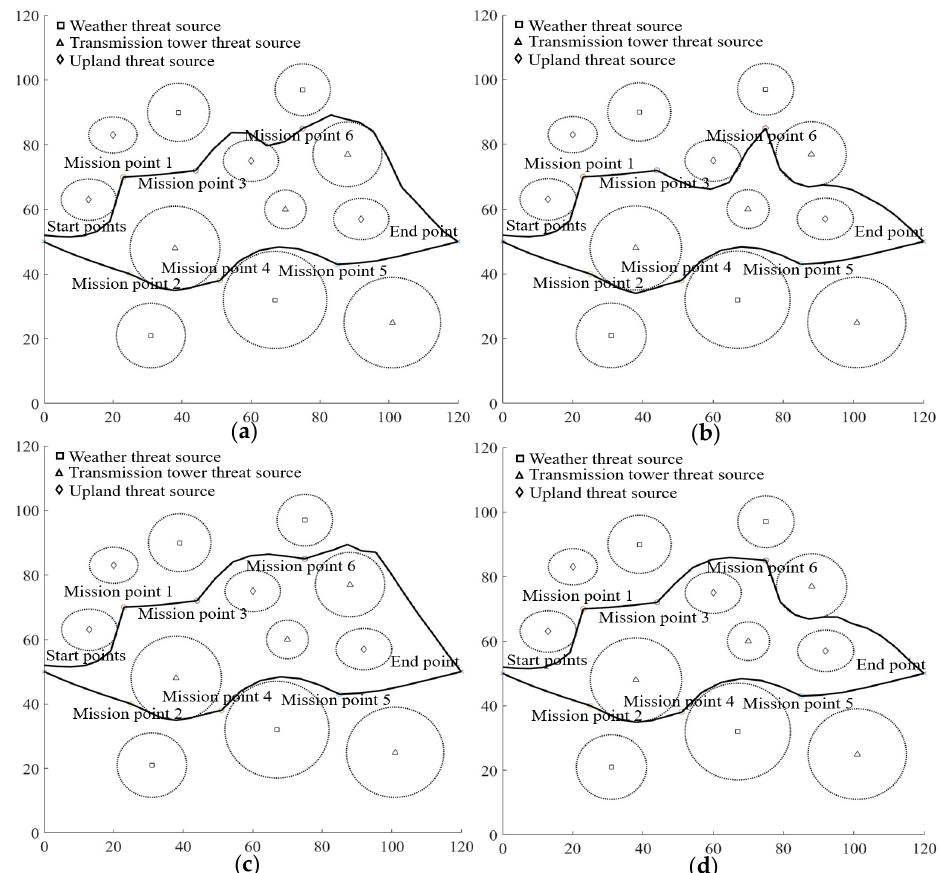
Figure 12. Results of multi-UAV optimal mission assignment and path planning using different methods. ( a ) Visualization results of GA+ABC. ( b ) Visualization results of GA+IABC. ( c ) Visualization results of AGA+ABC. ( d ) Visualization results of